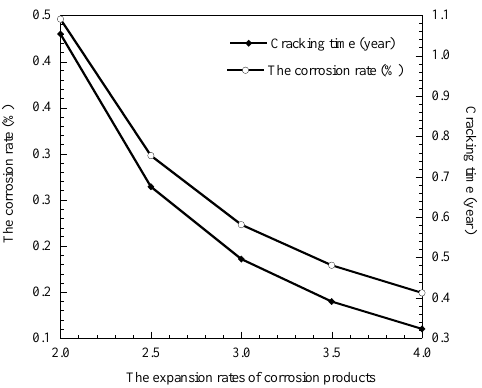
Figure 4. Relationship between corrosion products expansion rates and corrosion rate as well as cover cracking time.